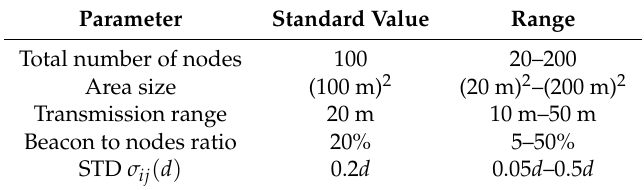
Table 1. A set of standard values used in the simulation, and variation ranges for these